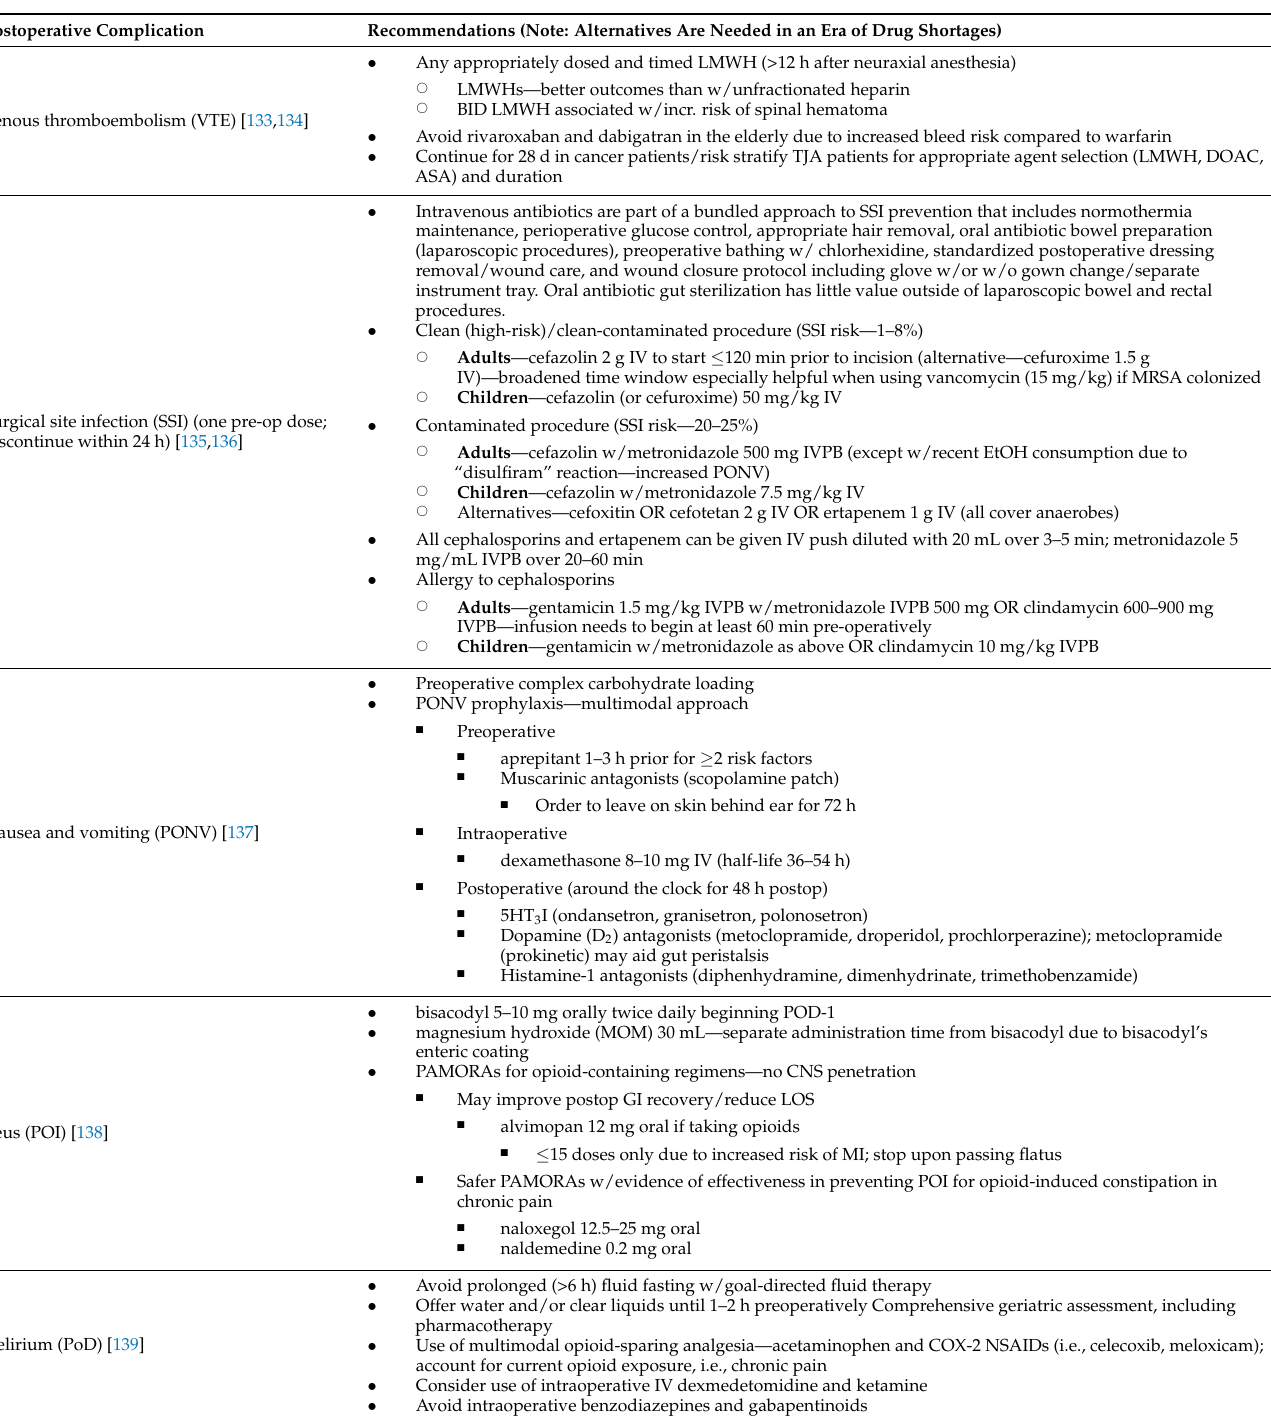
Table 5. Summary of Pharmacotherapy Recommendations for Preventing Common